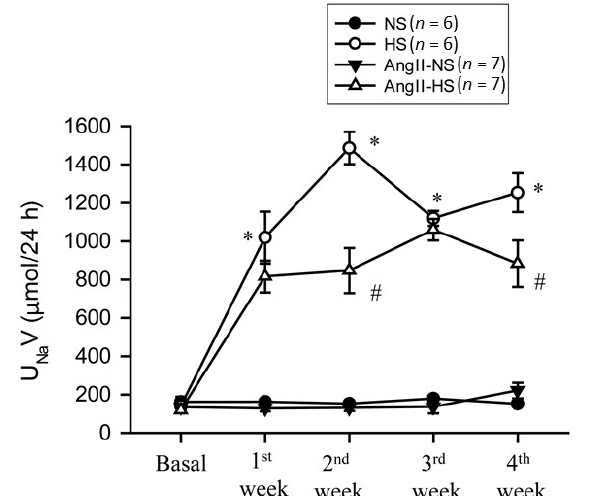
V responses to chronic AngII (25 ng/min) infusion in mice given NS (NS; 0.3% NaCl) and HS (HS; 4% NaCl) Figure 4. U Na containing diets. * : P < 0.05 vs. NS; #: P < 0.05 vs.